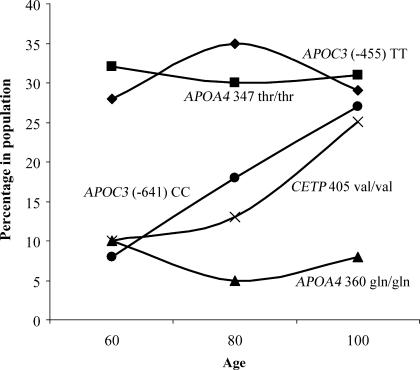
Distribution of “Favorable” Gene Polymorphisms of
APOC3, APOA4, and
CETP in the Study Population
The genotype frequencies of the favorable gene polymorphisms of
APOC3 C(−
641)A and
CETP I405V were analyzed in controls and probands (60 to 100 y old). (Offspring were not included in this analysis due to the genotype dependency of this group on proband genotypes.) The frequency of these two variants was found to be higher among centenarians, with a monotonic increase with age. Other polymorphisms in these same genes (
APOC3 (−455) TT,
APOA4 347 TT, and
APOA4 360 EE) showed no differences in genotype frequency with age.